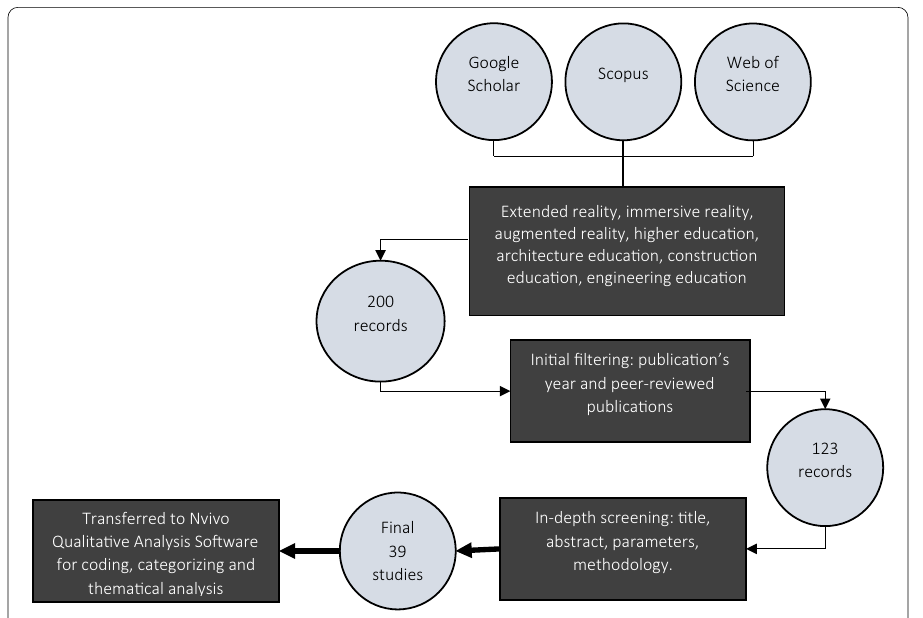
Fig. 2 Methodology diagram illustrating the process of data